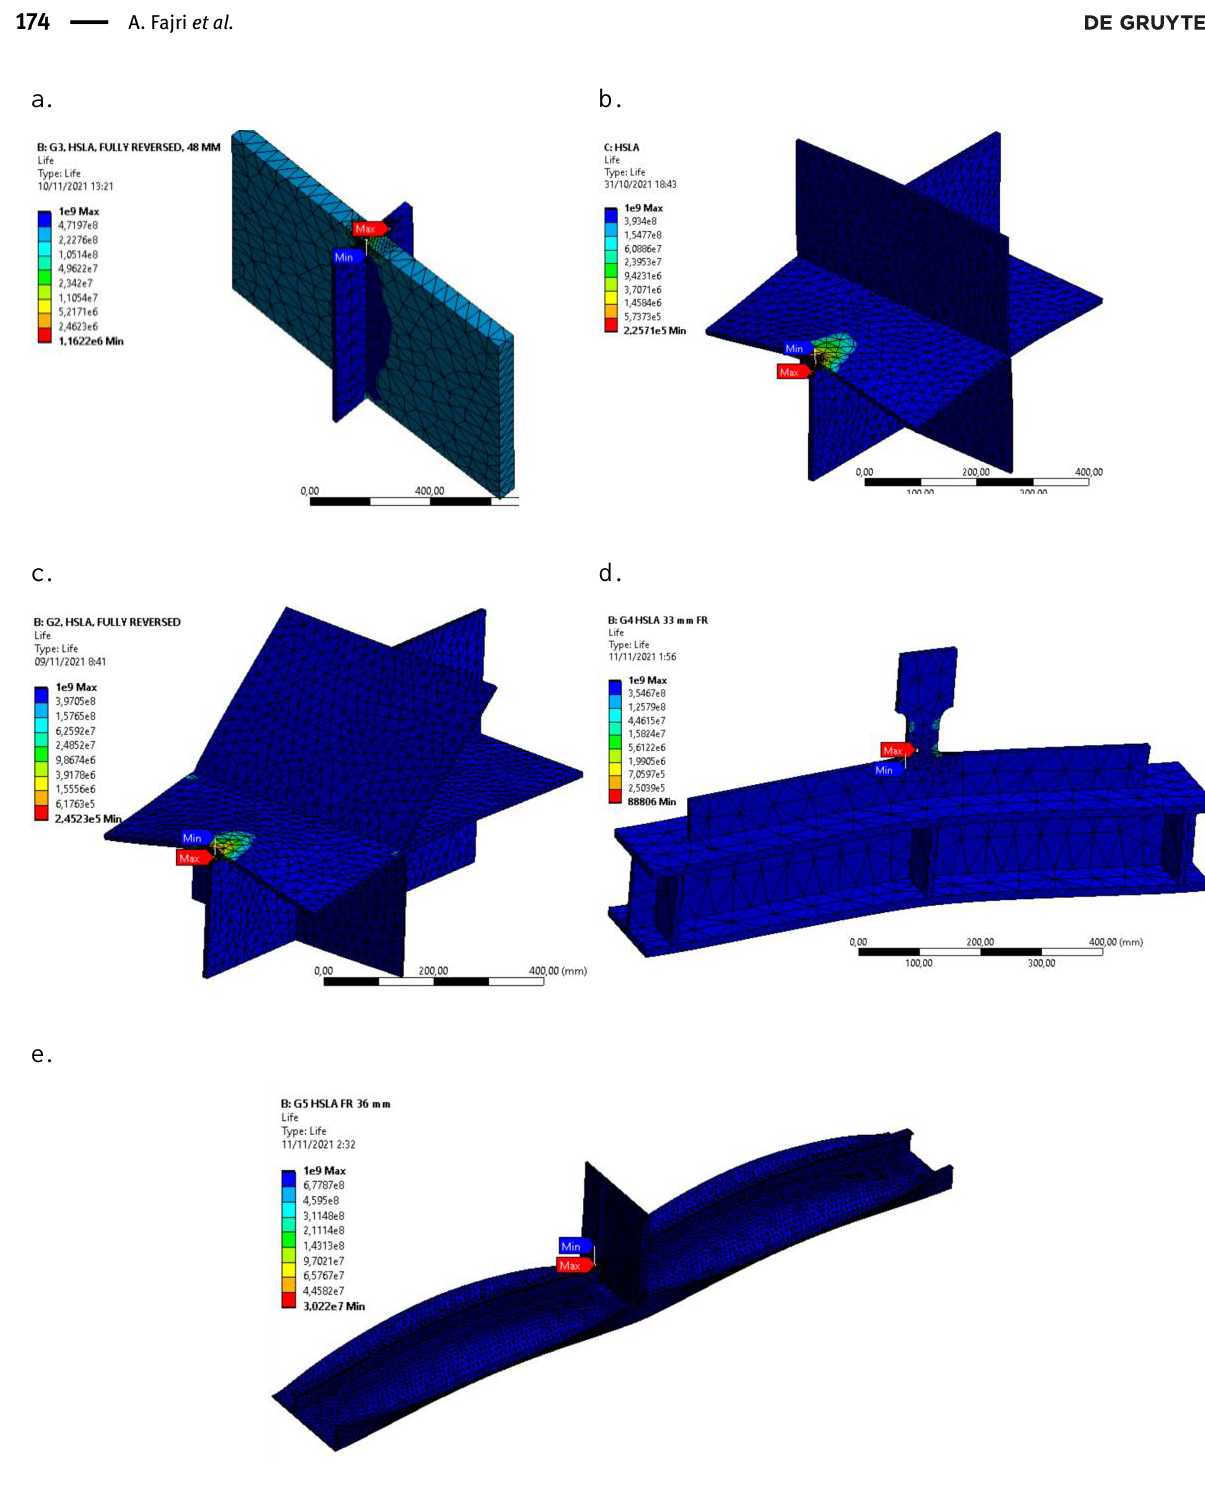
Figure 13. Fatigue Life Results: a. Geometry 1: Hatch Coaming Model [16]; b. Geometry 2: Perpendicular Joint Figure 13: Fatigue life results: a. Geometry 1: Hatch coaming model [16]; b. Geometry 2: Perpendicular joint [12]; c. Geometry 3: Stool joint [12]; c. Geometry 3: Stool Joint [12]; d. Geometry 4: Bottom-Stiffened Panel [27]; e. Geometry 5: Side-Stiffened [12]; d. Geometry 4: Bottom-stiffened panel [28]; e. Geometry 5: Side-stiffened panel Panel [28]